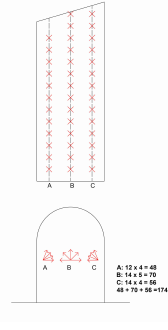
Figure 11 – Dense Point Cloud Figure 10 – Previous focused on central intrados area and study of camera camera locations in the central row. locations.